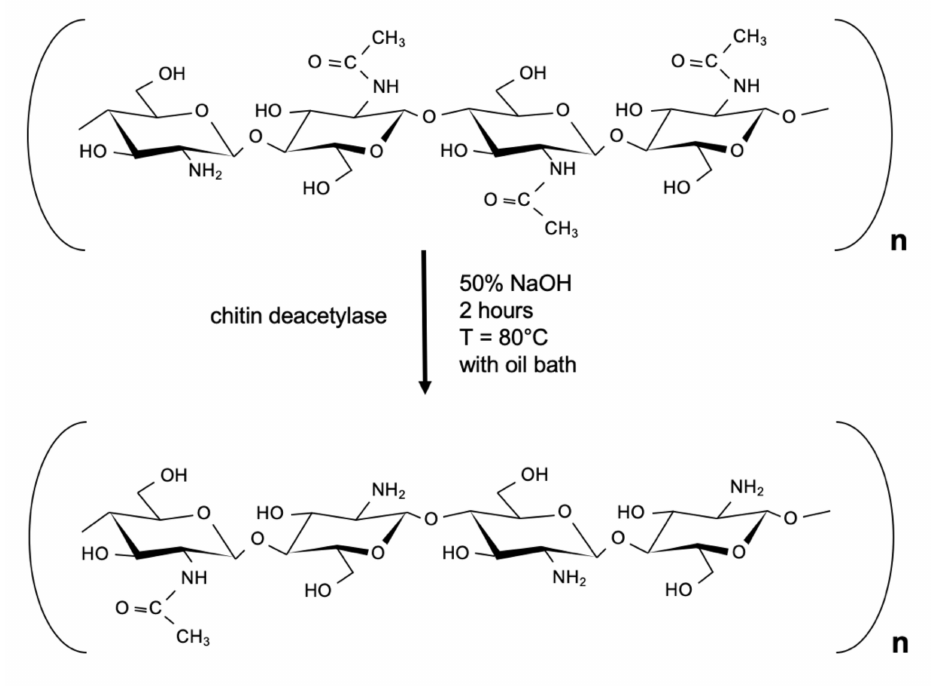
Figure 3. The reaction of chitin deacetylation with chitin